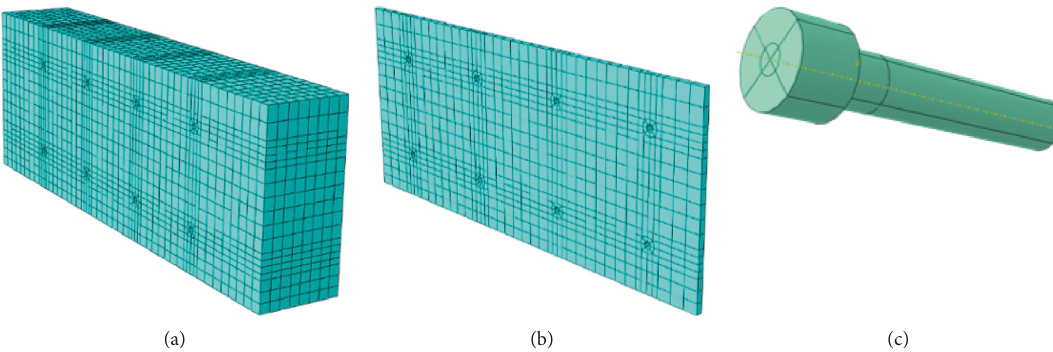
Figure 14: FE mesh discretization. (a) Concrete beam. (b) SFRC panel. (c)